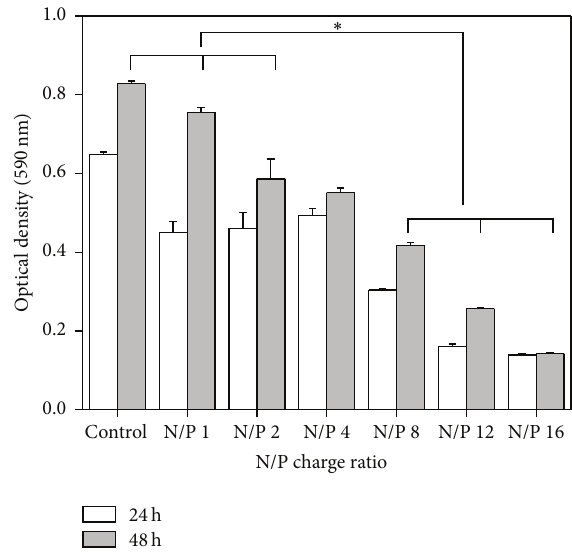
Figure 3: Viability of hTMSCs treated with DNA-PEI NPs at various N/P charge ratios, measured by the MTT assay ( ∗ 𝑃 < 0.001 ).